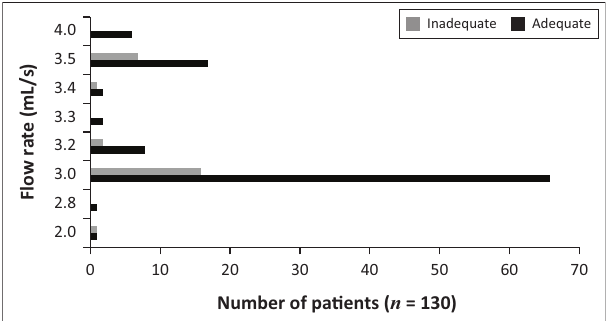
FIGURE 3: Frequency of adequate and inadequate contrast-enhanced CTPAs in the prospective group of patients for different flow